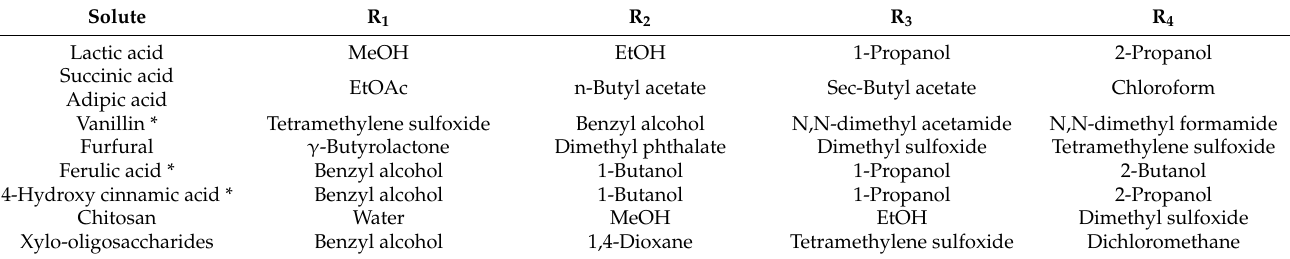
Table 12. Chosen solutes of interest and the solvents closest to them in Hansen space. Solute R 1 R 2 R 3 R